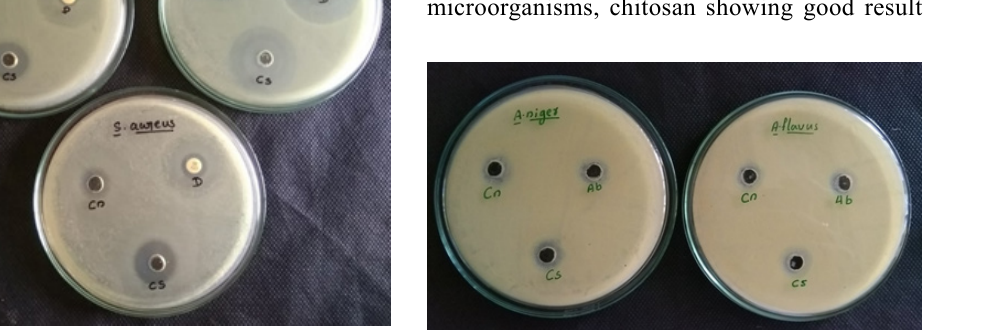
Fig. 9. Antibacterial activity against B.cereus, E.coli and S.aureus from the figure cn-chitin, cs-chitosan, D- antibiotic disc